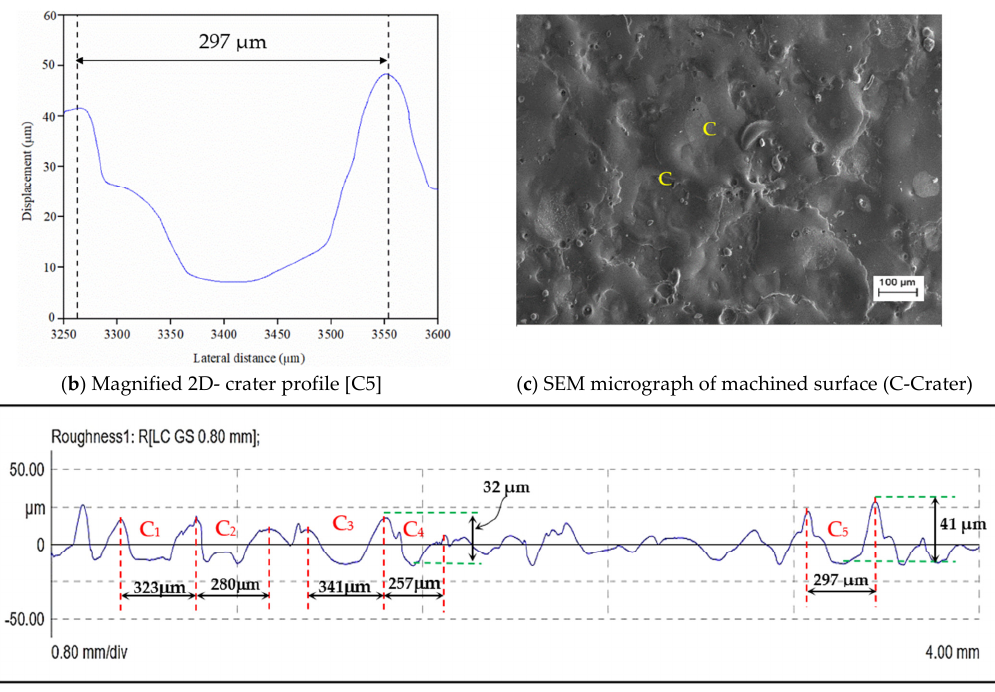
Figure 5. Simulated and experimentally formed carter geometry for Φ 40 µ m at T d = 300 µ s, I p = 6 A, V g = 80 V.